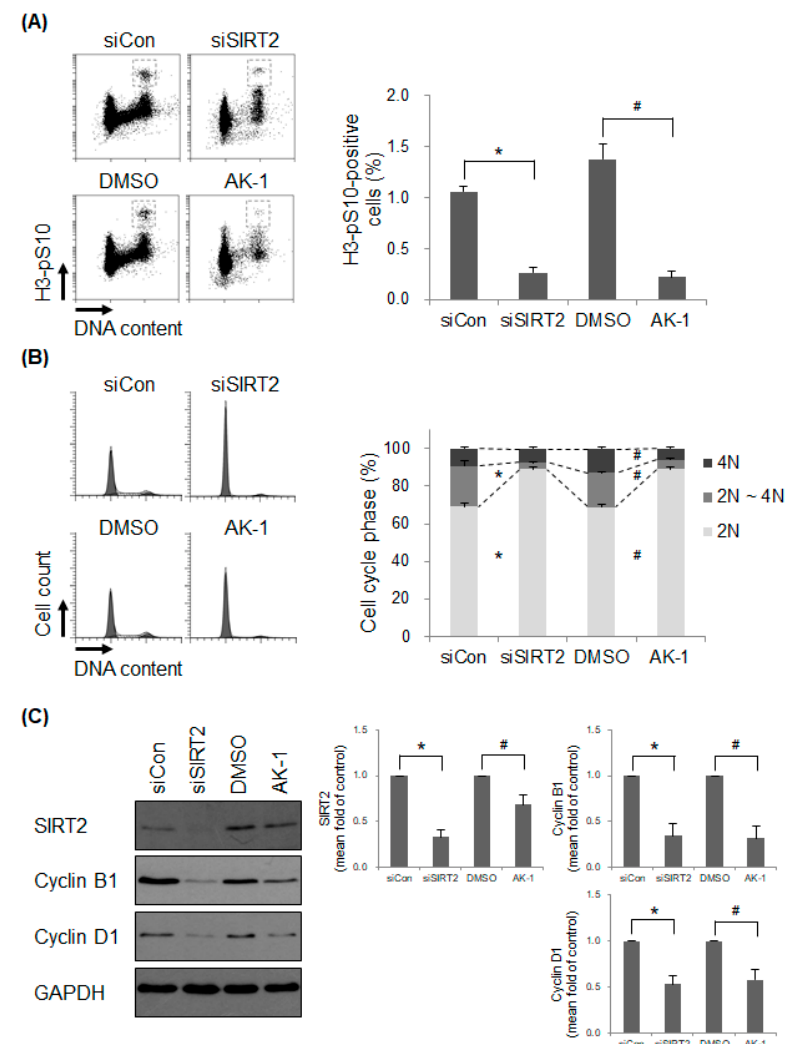
Figure 2. Suppression of SIRT2 induces cell cycle arrest at G0/G1 phase. ( A – C ) hTERT-RPE1 cells were transfected with control siRNA (siCon) or SIRT2-targeting siRNA (siSIRT2), or treated with 0.1% DMSO or 10 µ M AK-1 for 48 h. ( A , B ) Mitotic cells and DNA content were determined by flow cytometry after staining cells with an anti-histone H3-pS10 antibody and propidium iodide. The proportion of mitotic cells ( A ) and the percentage of cells at each phase of the cell cycle ( B ) are expressed as the mean ± SEM ( n = 5). * p < 0.05 and # p < 0.05; significantly di ff erent from siCon-transfected and DMSO-treated cells, respectively (unpaired Student’s t -test). ( C ) Expression of each protein was evaluated by Western blotting. Relative expression is presented as the mean ± SEM ( n = 4). * p < 0.05 and # p < 0.05; significantly di ff erent from siCon-transfected and DMSO-treated cells, respectively (Mann–Whitney U